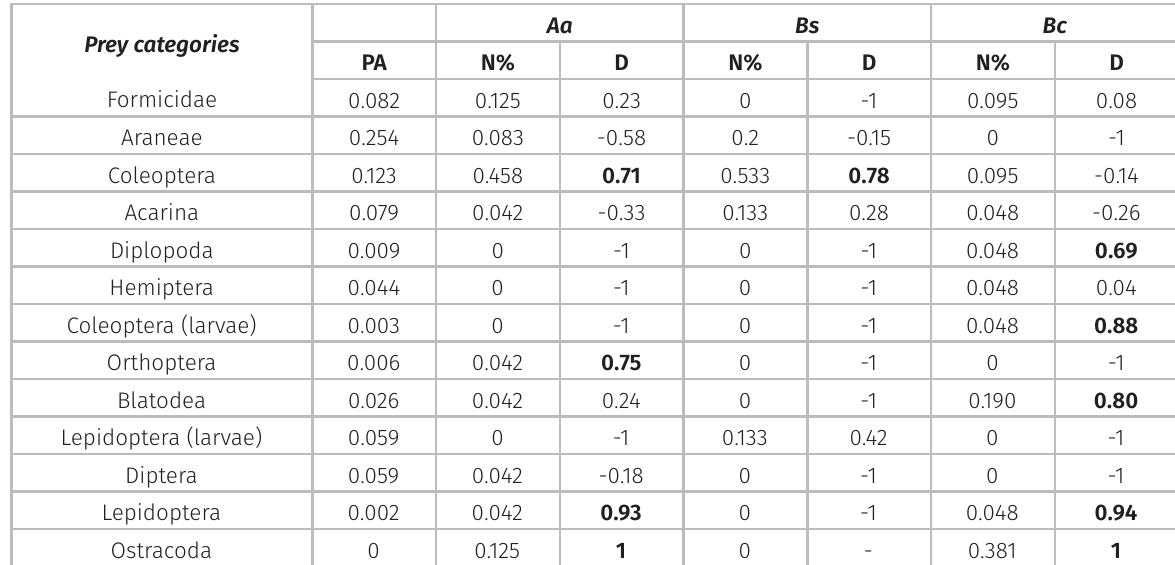
Table III. Index of electivity of prey of tree species Aplastodiscus albosignatus ( Aa ), Boana semiguttata ( Bs ) and Bokermannohyla circumdata ( Bc ). Legend: PA = Availability of tree prey, n% = number of prey, D = Jacobs electivity index. Red values indicate prey